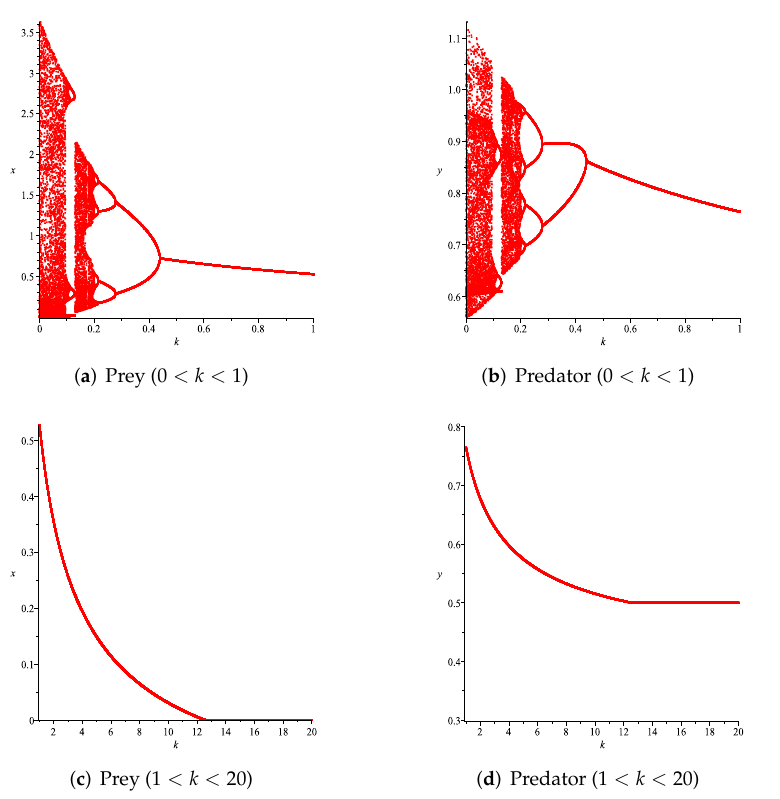
Figure 9. Variation of prey and predator densities with parameter k . The phase portraits correlated with Figure 9 are displayed in Figure 10, which includes orbits of periods 2, 4, and 8. When k = 0.005 , we can see chaotic sets in Figure 10a.